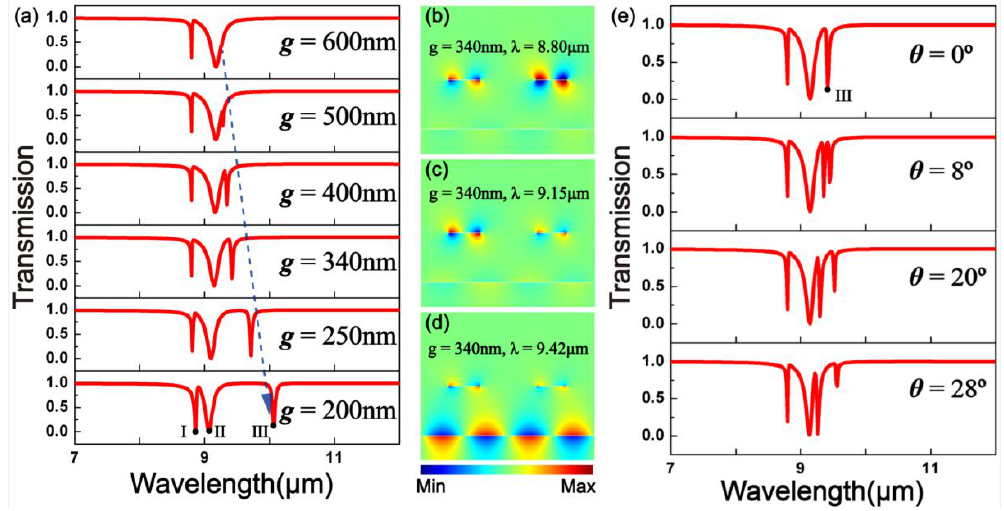
Figure 4. ( a ) Transmission spectra of structure I at different gap g values between the graphene sheet and the GNRs; ( b – d ) The field distributions E y of the transmission dips under g = 340 nm; ( e ) Spectral responses of structure I with different angles of incidence.